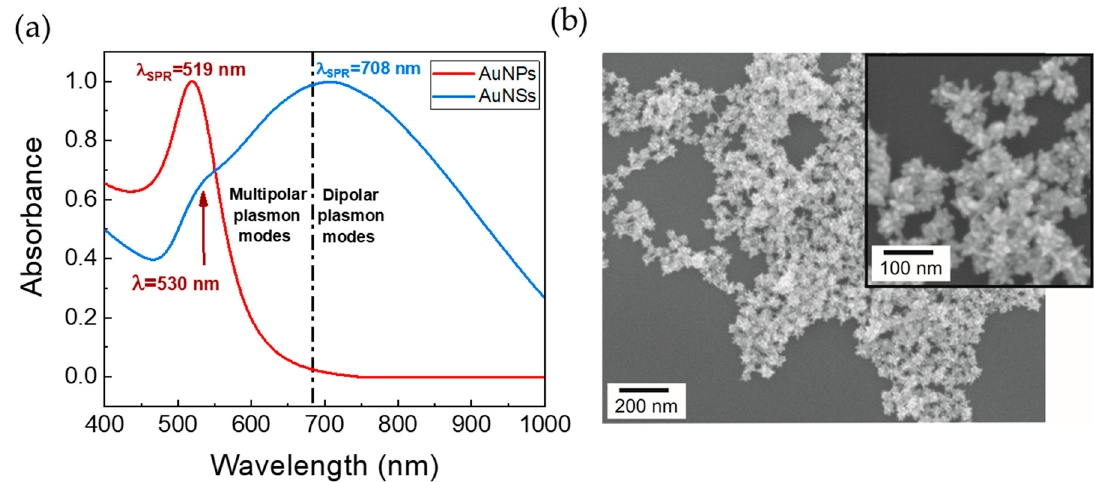
Figure 2. ( a ) UV-Vis spectra of AuNPs (red line) and AuNSs (blue line). The Ojea-Jimin é z [29] synthesis method allowed a diameter of 12 nm ( λ LSPR = 519 nm) for AuNPs. The AuNSs present an LSPR band centered approximately at 670 nm and a large broadening. ( b ) SEM micrograph of AuNSs after synthesis.